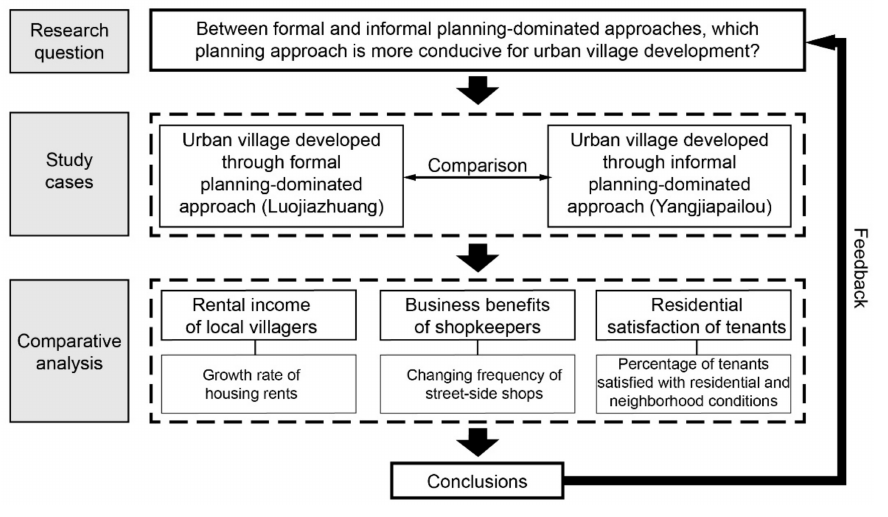
Figure 4. Analytical framework.